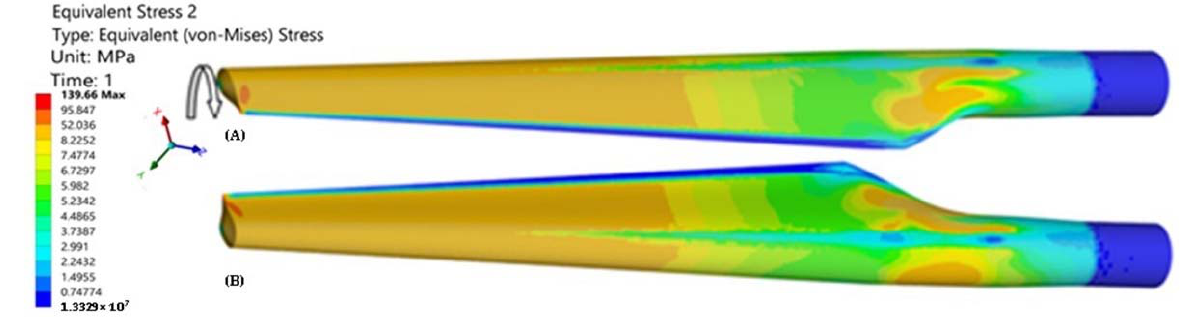
Figure 8. The gradient of stresses in the blade: ( A ) extrados; ( B ) intrados.